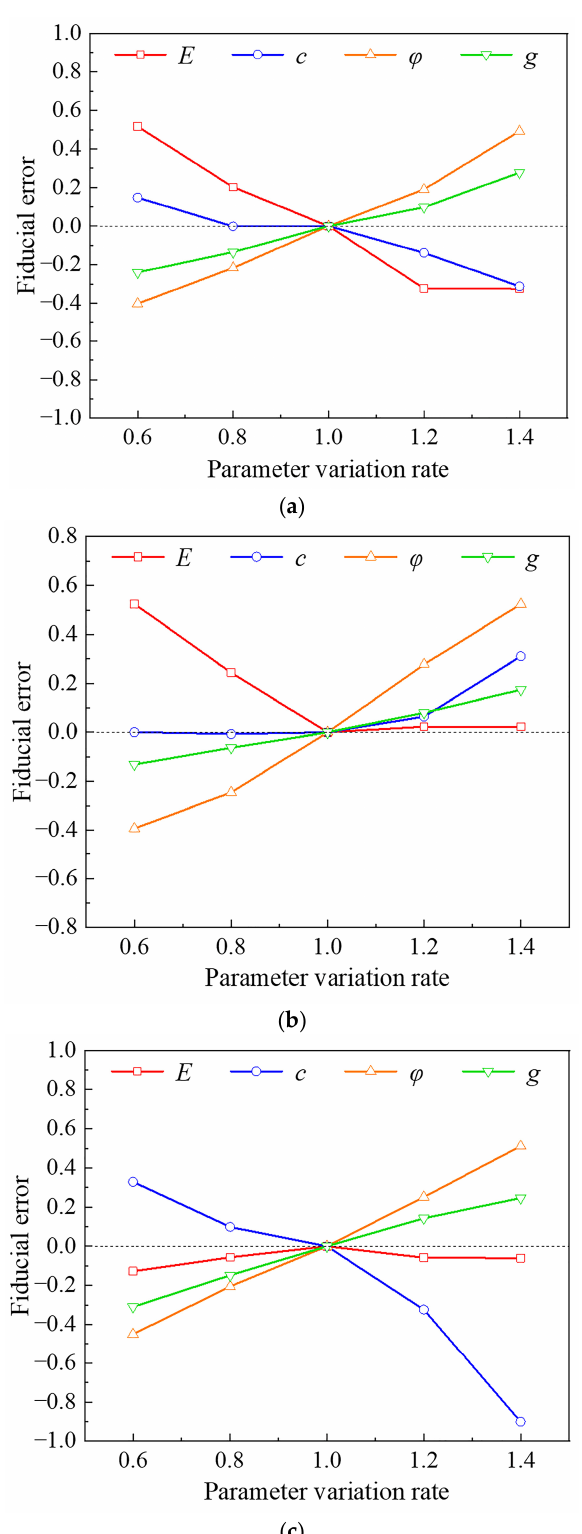
Figure 8. Key unit dynamic axial force reference value error curve. ( a ) A1; ( b ) B1; ( c ) B2.